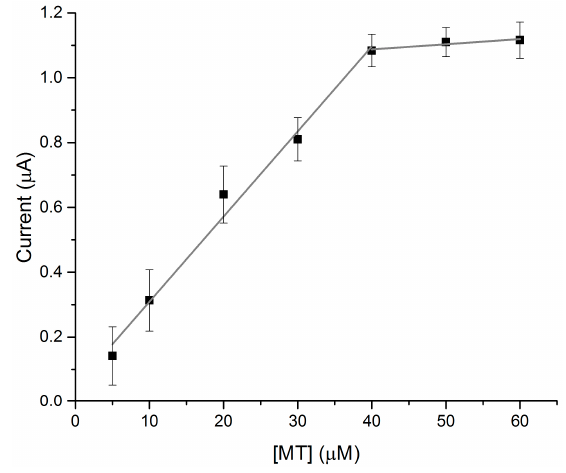
Figure 2. Influence of paper disc MT-loading on the peak heights of the S Cys responses at +0.22 V in the electrochemical scans. The MT concentrations of each of the 20 μ L aliquots added to the paper discs are plotted on the x-axis ( n = 3).